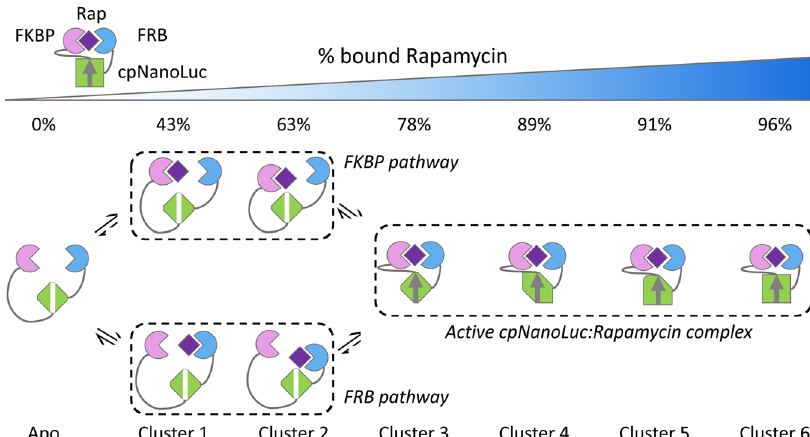
Fig. 5 Model of the FKBP-cpNanoLuc-FRB conformational activation. Rapamycin (purple) binds to the FKBP (pink) and FRB (blue) domains and stabilizes a “ closed ” form of the central cpNanoLuc (green) domain in which the β -10 strand has intercalated into the β -sheet. The centroid of each cluster has its midpoint at the given %bound rapamycin. Parallel pathways exist for ligand binding, though the central pathway (simultaneous FKBP/FRB binding to rapamycin) is improbable. Few structural changes were observed beyond 1:1 stoichiometry of binding where the biosensor is estimated 89% bound